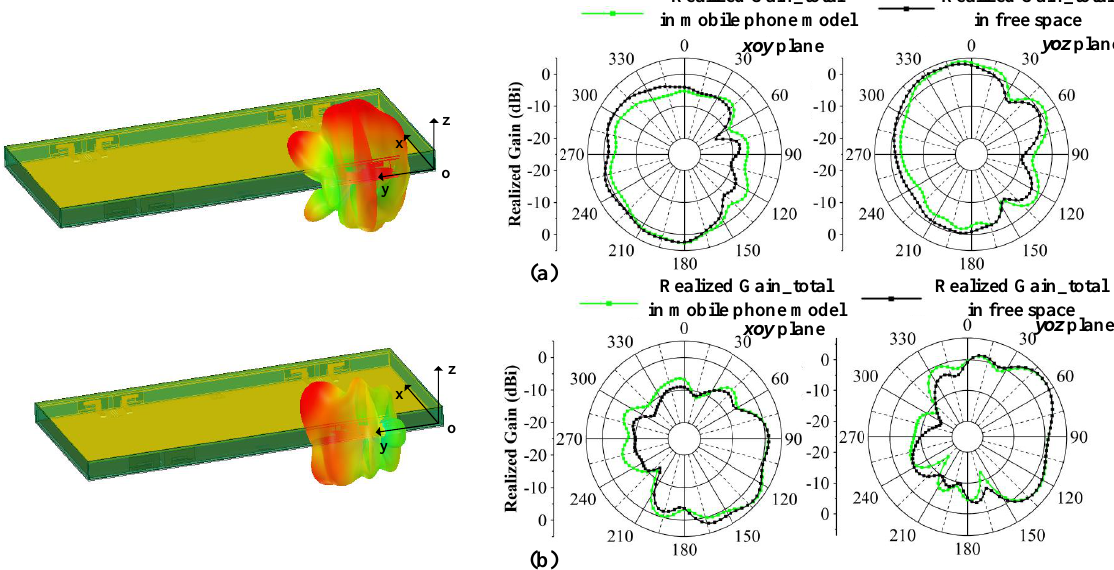
Figure 26. Radiation pattern of MIMO system with mobile phone model observed from 4.5 GHz. ( a ) 3-D and 2-D radiation pattern of Ant 1. ( b ) 3-D and 2-D radiation pattern of Ant 2.